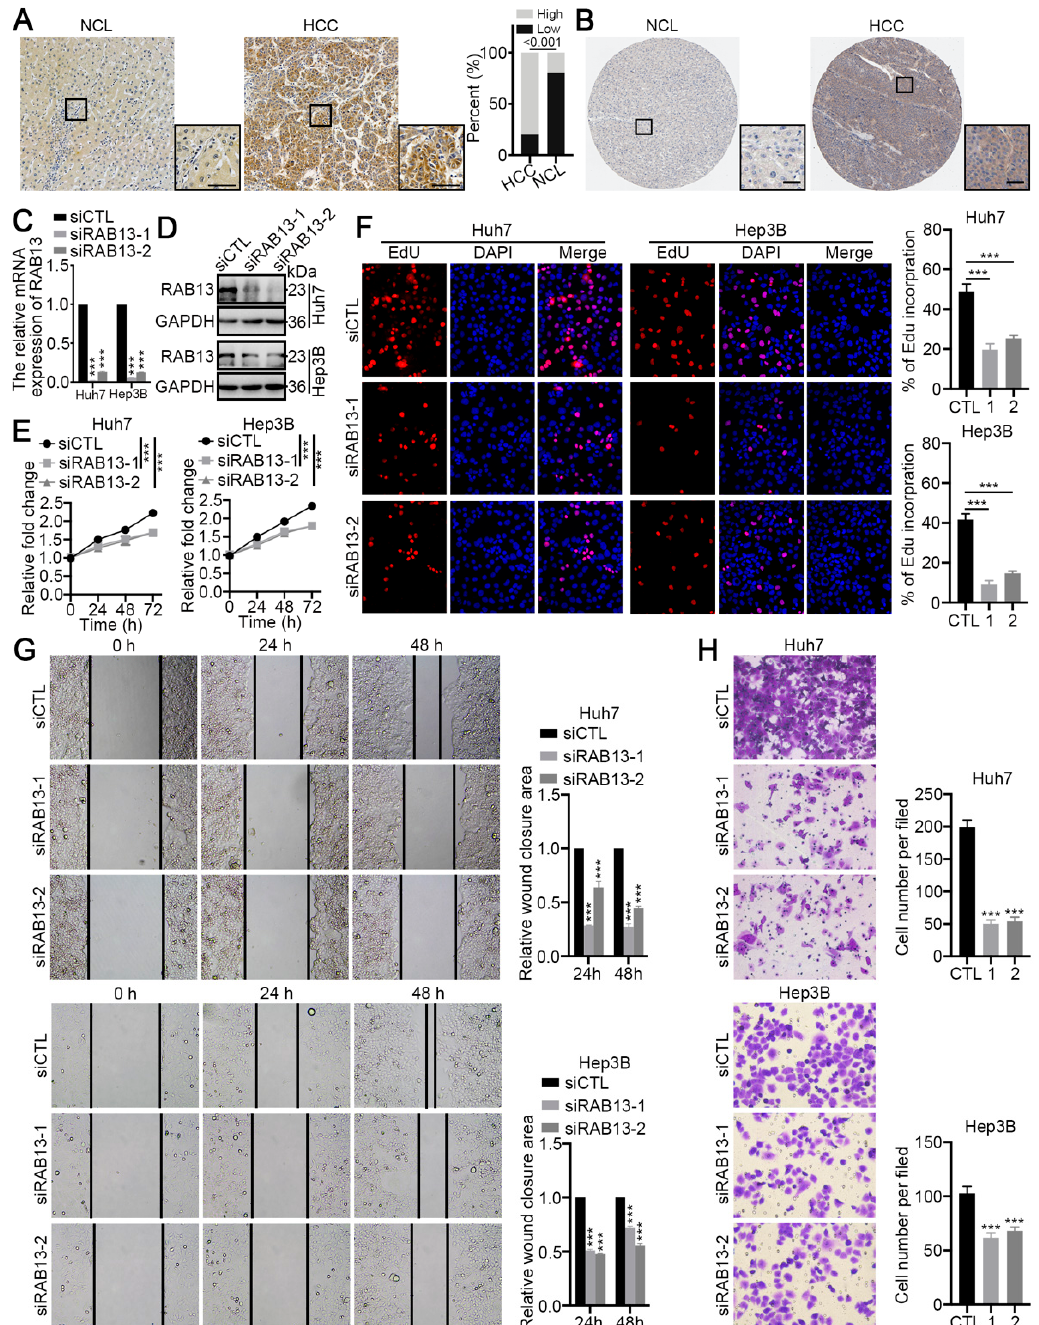
Figure 9. RAB13 promotes the proliferation and metastasis of HCC cells. ( A , B ) Representative IHC images of RAB13 in HCC and nontumor liver tissue (NCL) from ( A ) our clinical samples and ( B ) the Human Protein Atlas. The scale bar denotes 50 μ m. ( C ) qRT ‒ PCR and ( D ) Western blotting for RAB13 in Huh7 and Hep3B cells transfected with RAB13 siRNAs (siRAB13) and control siRNA (siCTL), respectively. ( E ) CCK-8 assays for Huh7 and Hep3B cells transfected with siRAB13 or siCTL over a 3-day period. ( F ) EdU assays for the indicated HCC cells transfected with siRAB13 or siCTL for 48 h. Magnification, 400×. ( G ) Wound healing (Magnification, 200×) and ( H ) Transwell assays for Huh7 and Hep3B cells transfected with siRAB13 or siCTL. Magnification, 400×. The results are presented as the means ± SDss, and three independent experiments (N = 3) were performed in triplicate. The student’s t-test was used for statistical analysis. The asterisks represent the statistical p value (*** p < 0.001).